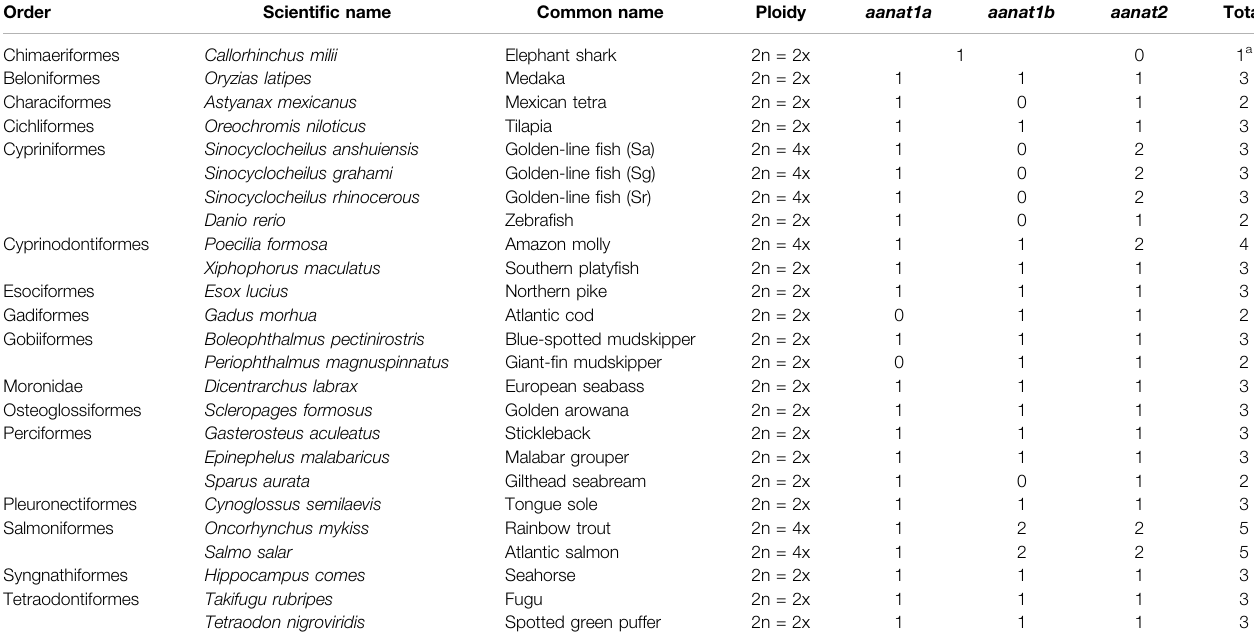
TABLE 1 | Copy number variations of aanat genes in various fi shes.